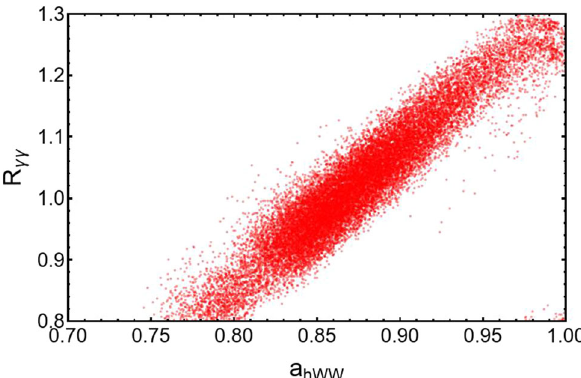
Fig. 5 CorrelationoftheHiggsdiphotonsignalstrengthwiththe a hWW deviation factor from the SM Higgs-W gauge boson coupling m 2 h where ρ i are the mass ratios ρ i = with M i = m f , M W ; 4 M 2 i α em is the fine structure constant; N C is the color factor ( N C = 1 for leptons and N C = 3 for quarks) and Q f is the electric charge of the fermion in the loop. From the fermion- loop contributions we only consider the dominant top quark is the trilinear coupling between term. Furthermore, C hH ± k H ∓ k the SM-like Higgs and a pair of charged Higges, whereas a htt